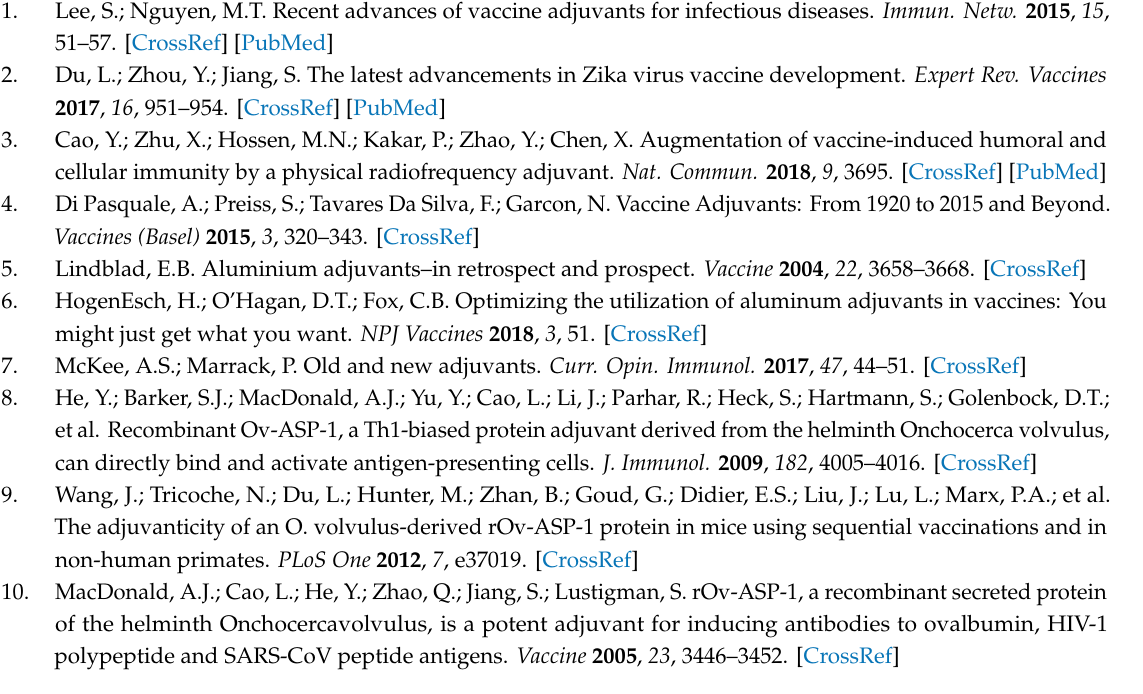
Figure S1: Induction of MERS-CoV-RBD specific IgG subtypes in sera of immunized mice, Figure S2: Representative flow cytometry plot determining the gating strategy of the immune cells recruited to the draining lymph nodes (LNs) of immunized mice, Figure S3: Number of monocyte and DC subsets recruited into the lymph nodes (LNs) of immunized mice, Figure S4: Frequency of CD4 + T cells in the lymph nodes (LNs) of immunized